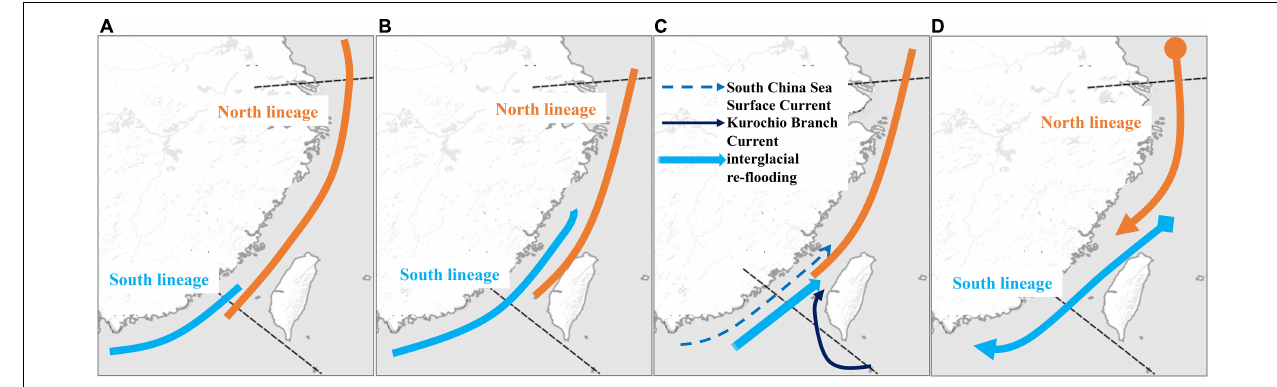
FIGURE 9 | Two scenarios of the mtDNA phylogeographic patterns, (A) southward scenario and (B) northward scenario. (C) The colonization history of the northward scenario proposed by Qiu et al. (2016). (D) The colonization history of Tridentiger bifasciatus inferred in this